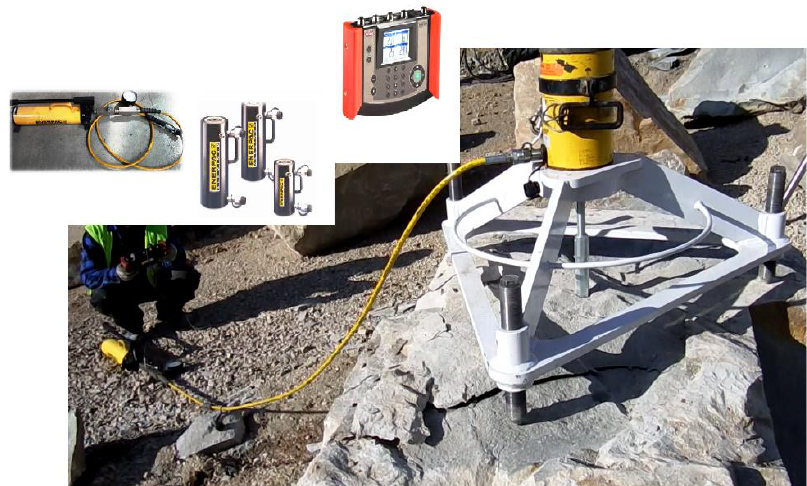
Figure 12. The mobile test stand.